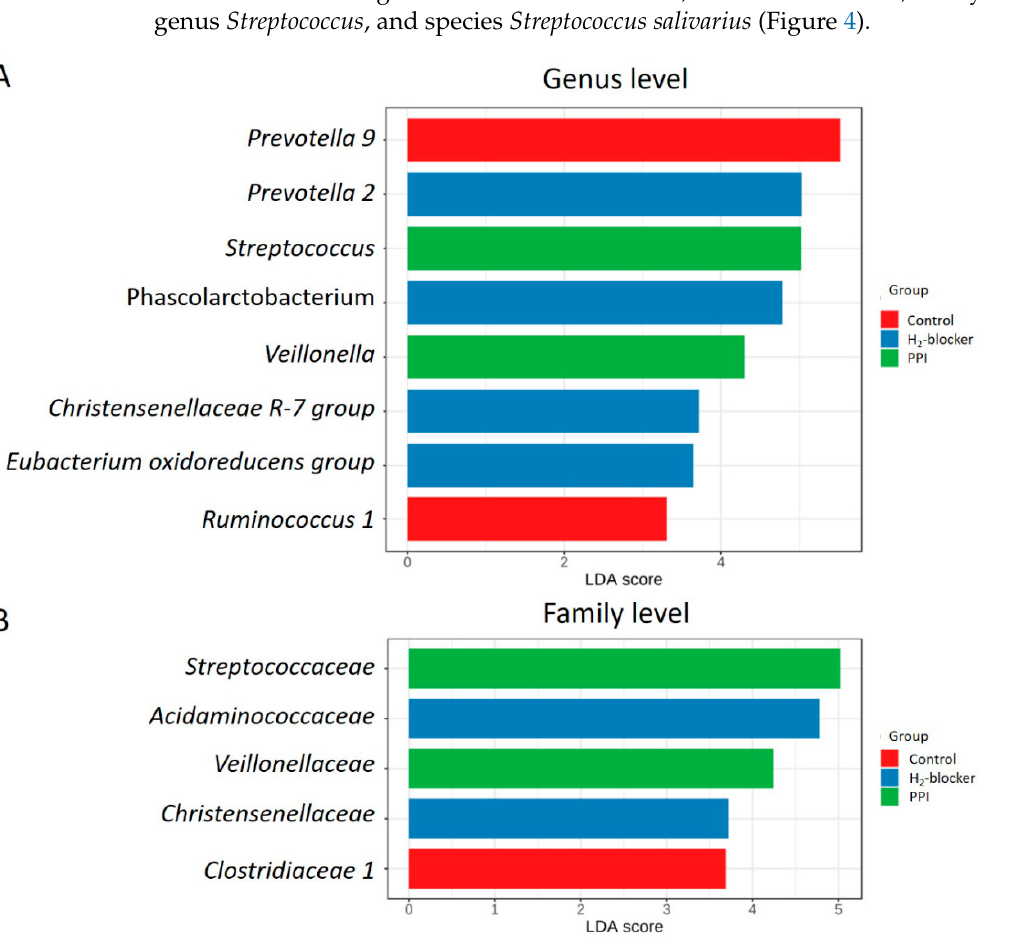
Figure 3. Linear discriminative analysis (LDA) effect size (LEfSe) analysis between H 2 -blocker users (blue), proton pump inhibitor users (green) and controls (red) at the ( A ) genus level and ( B ) family level.